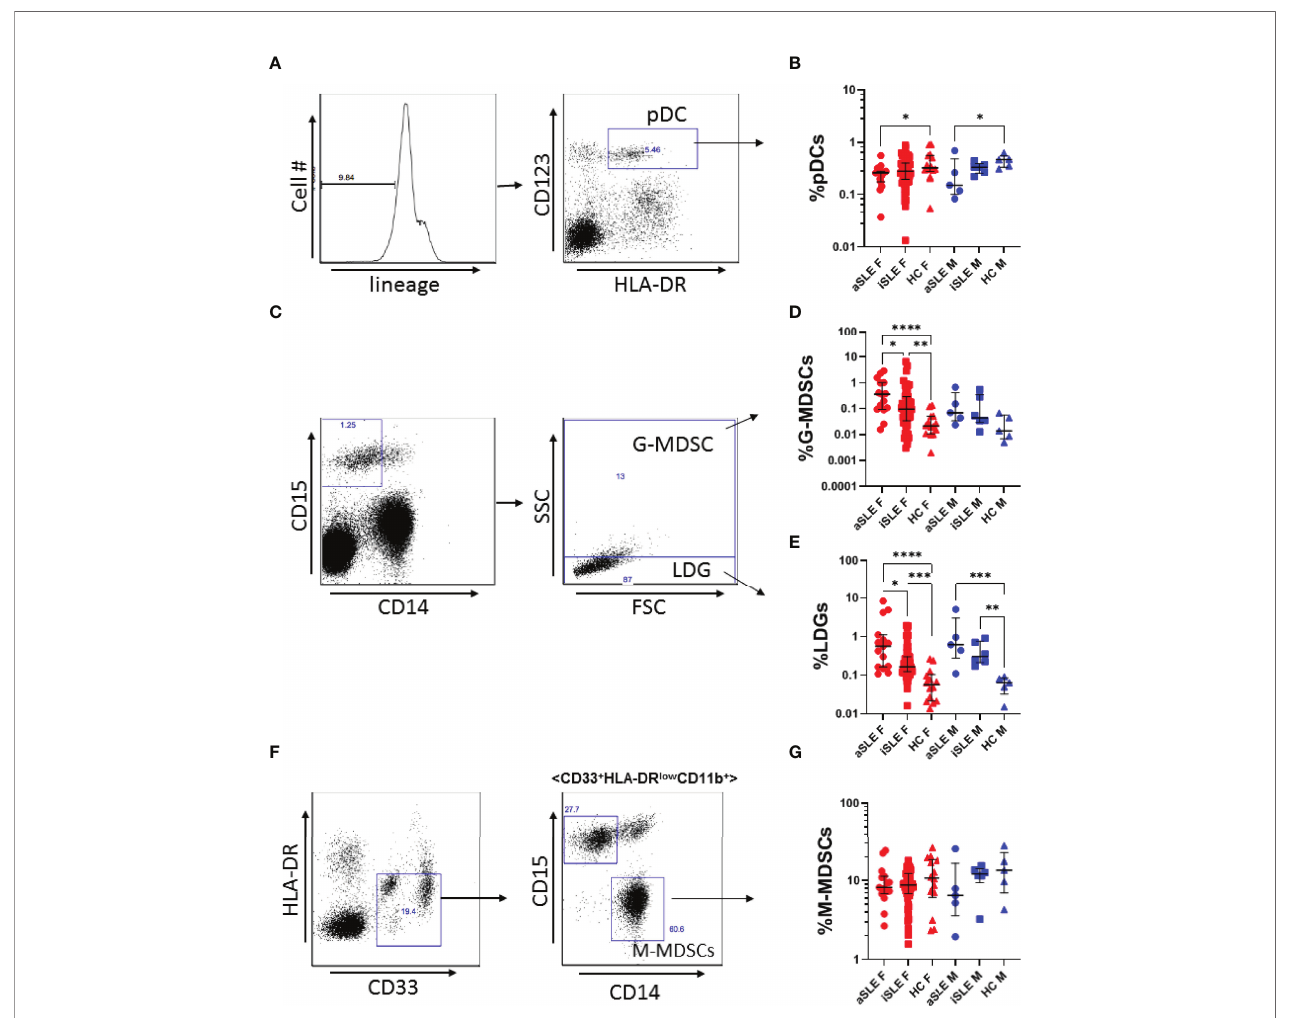
FIGURE 1 | Plasmacytoid dendritic cells are under expressed, while LDGs and G-MDSCs are overexpressed in SLE. (A) Representative gating strategy for pDC identi fi cation. PBMCs were fi rst gated as Lin - , and subsequently gated as CD123+, HLA-DR+. (B) pDC expression was decreased among males and females with active SLE. (C) Representative gating strategy for LDGs and G-MDSCs. LDGs were identi fi ed as CD15+CD14-SSC low , while G-MDSCs were identi fi ed as CD15 +CD14-SSC high . (D) G-MDSCs and (E) LDGs were signi fi cantly increased among males and females with SLE. (F) Representative gating strategy for M-MDSCs. M- MDSCs were fi rst identi fi ed as HLA-DR-, CD33+, and then gated for CD11b+, before gating as CD15-, CD14+. (G) M-MDSCs frequency was consistent among SLE patients and healthy controls. Comparisons were made using Kruskal-Wallis Test with Dunn ’ s test for multiple comparisons. Bars represent median and interquartile range. aSLE F (N = 15), iSLE F (N = 50), HC F (N = 14), aSLE M (N = 5), iSLE M (N = 6), HC M (N = 5). *p < 0.05; **p < 0.01; ***p < 0.001; ****p <